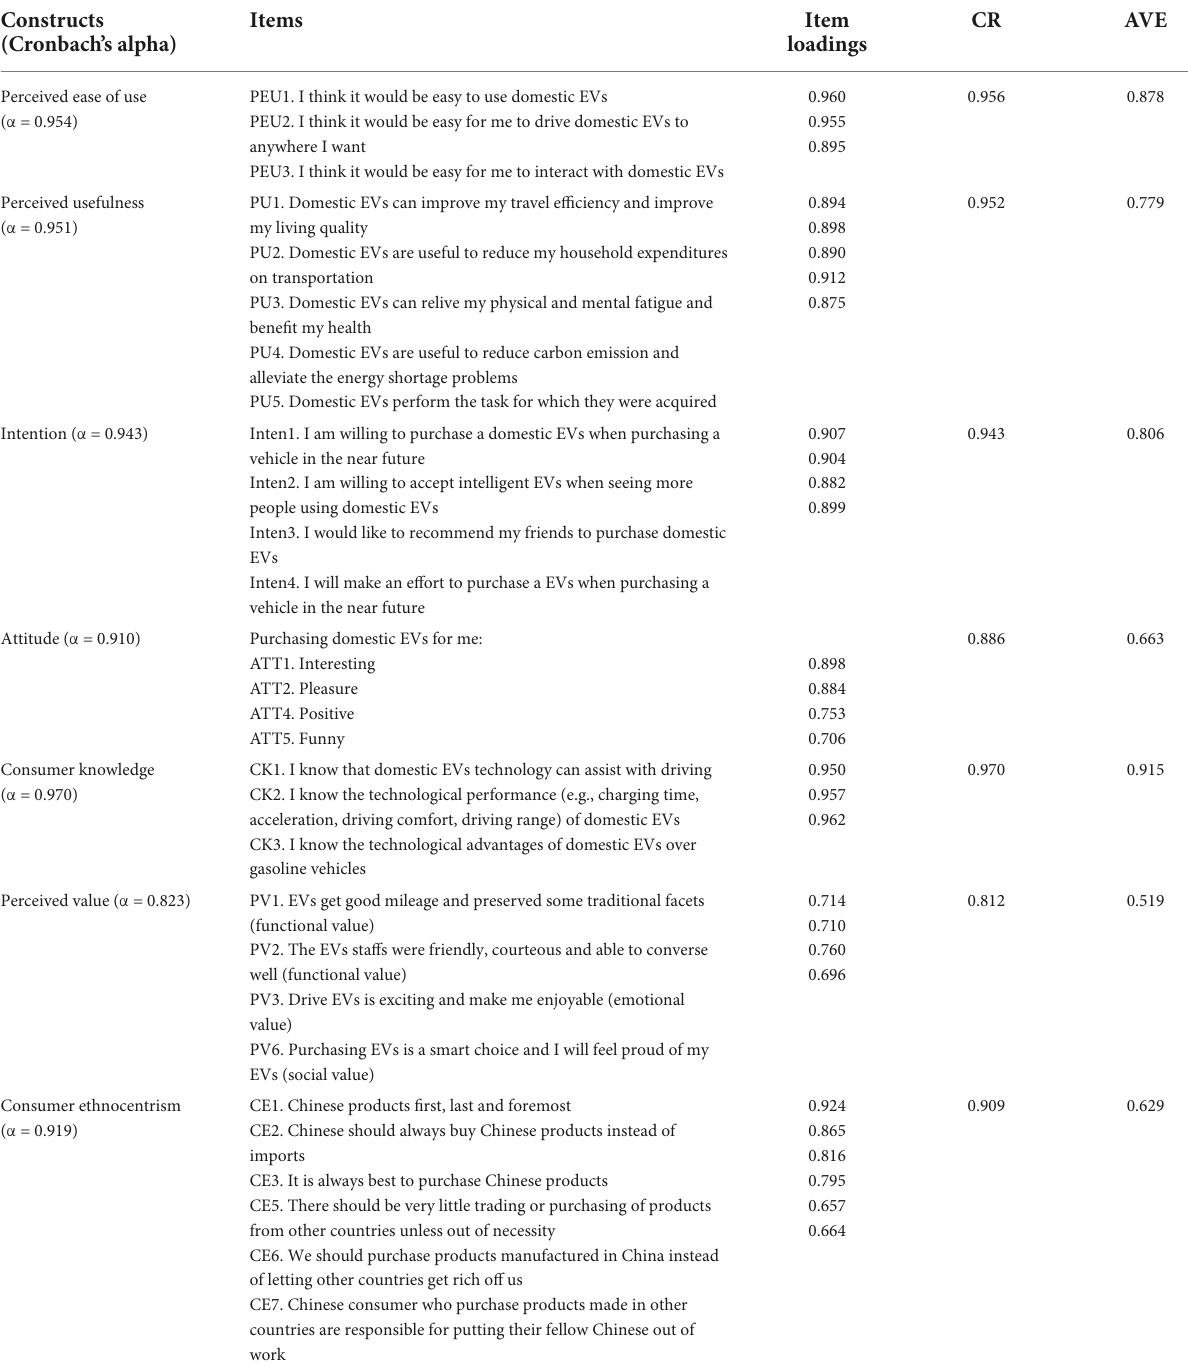
TABLE 2 Convergent validity for measurement